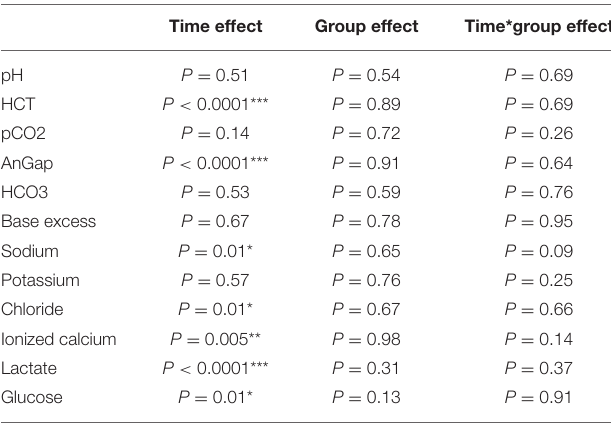
TABLE 3 | GLM analysis for repeated data on all